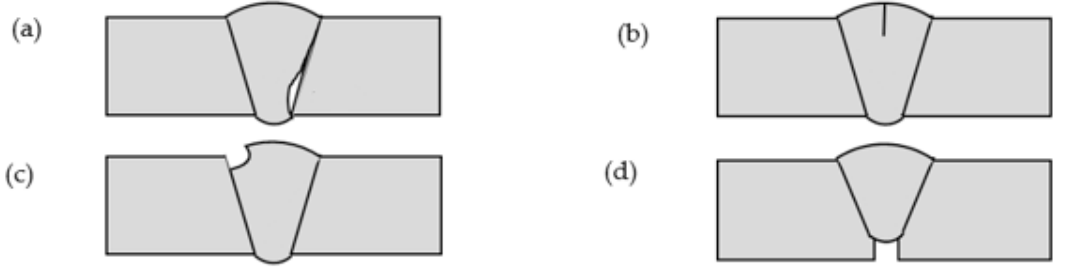
Figure 13. Welding defects ( a ) Lack of fusion; ( b ) Cracks; ( c ) Undercut; ( d ) Lack of penetration. In addition to the welding part, the pipeline also suffered from load and environmental Table 1. Test matrix for computation modeling. erosion. Hence, the notch-shaped damages of different positions were considered in the research, representing minute cracks with a width of around 10 − 4 m. The damage depth was 4 mm and the length was 0.1 × D out . The damage locations ranged from 0.5 × D out to 10 × D out